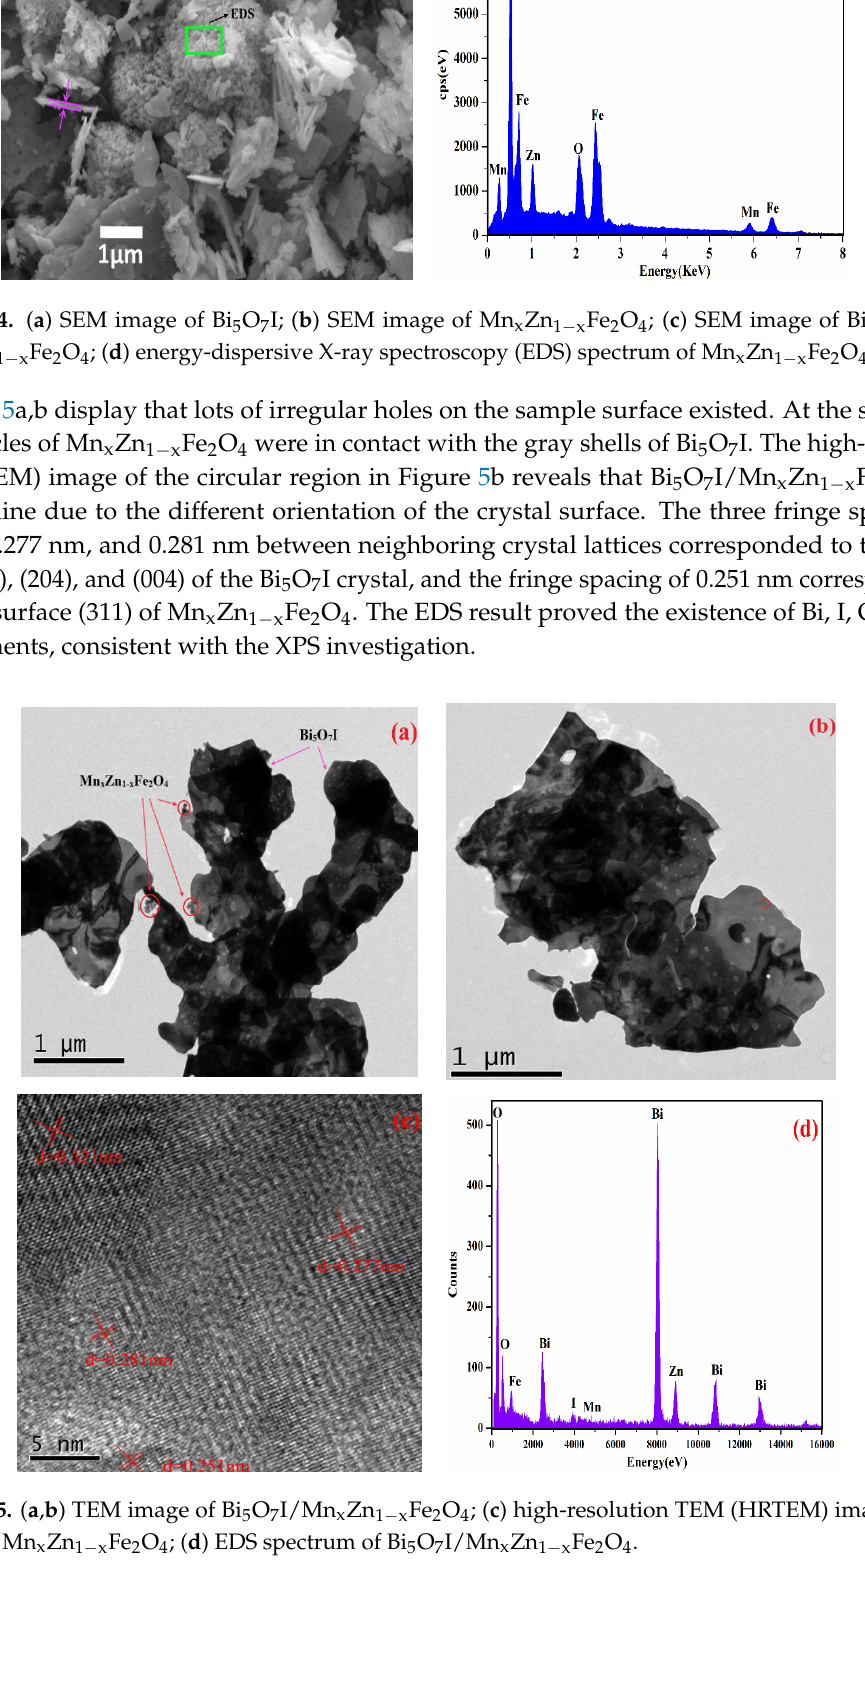
Figure 6. The N 2 adsorption – desorption isotherm of Bi 5 O 7 I/Mn x Zn 1 − x Fe 2 O 4 . The pore diameter distribution curve is shown in the inset image. 3.2. Absorption Light Ability and Magnetic Properties